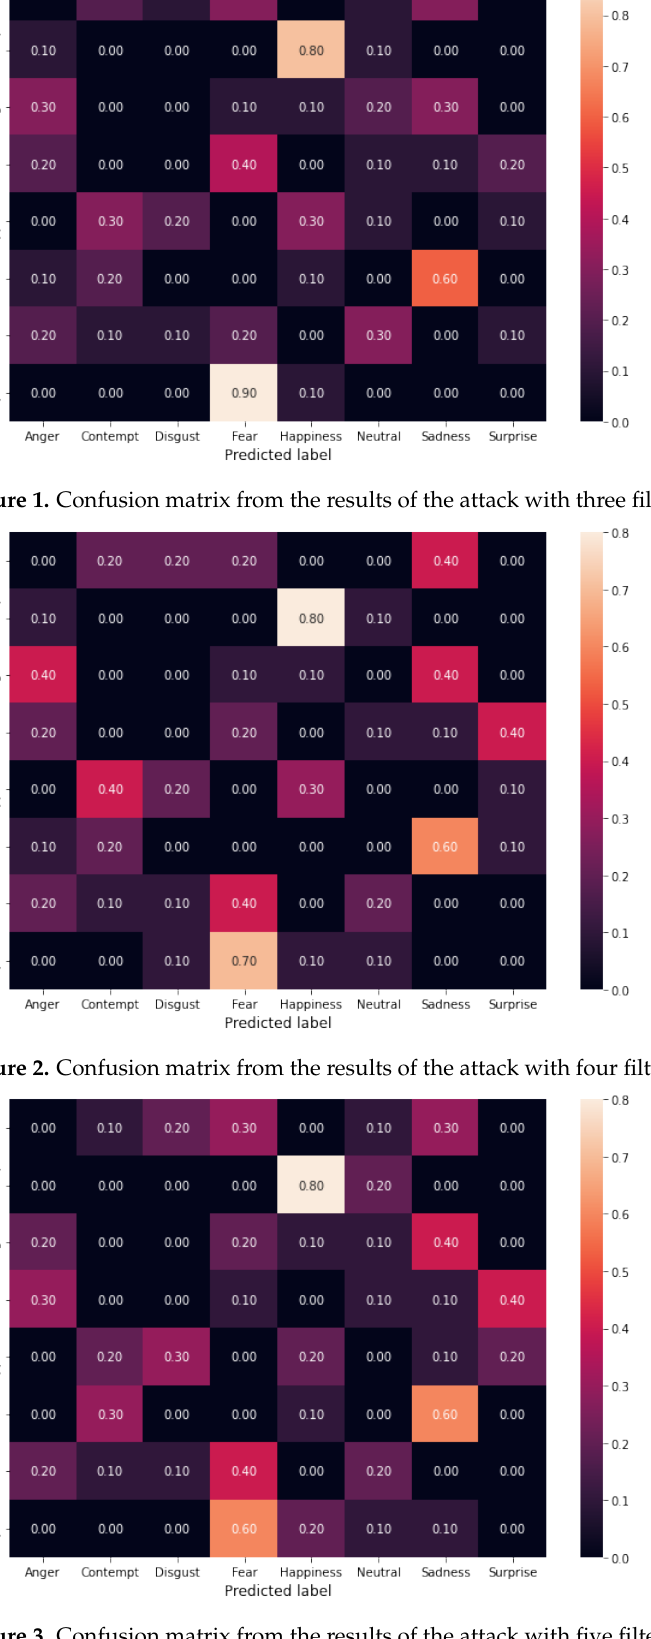
Figure 3. Confusion matrix from the results of the attack with five